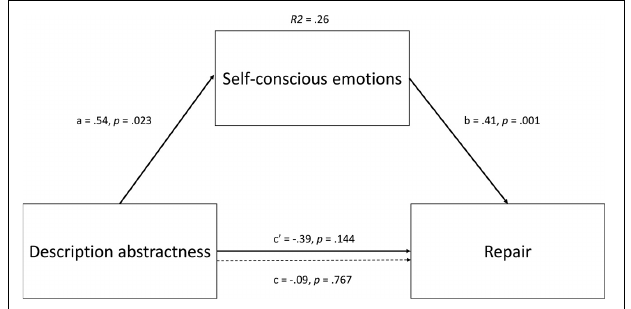
FIGURE 2 | Direct and indirect effects in model 4 when spatial distance is entered as covariate. Dotted line denotes the effect of description abstractness on repair when self-conscious emotion is not included as a